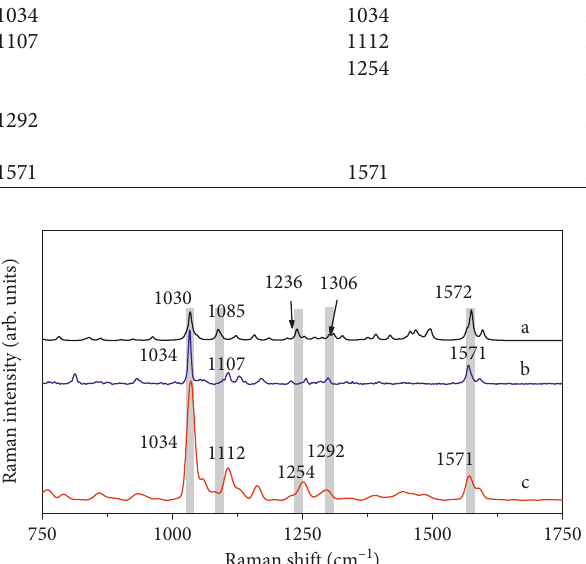
Figure 4: Promethazine: (a) theoretical Raman spectra, (b) solid Raman spectra, and (c) SERS spectra.